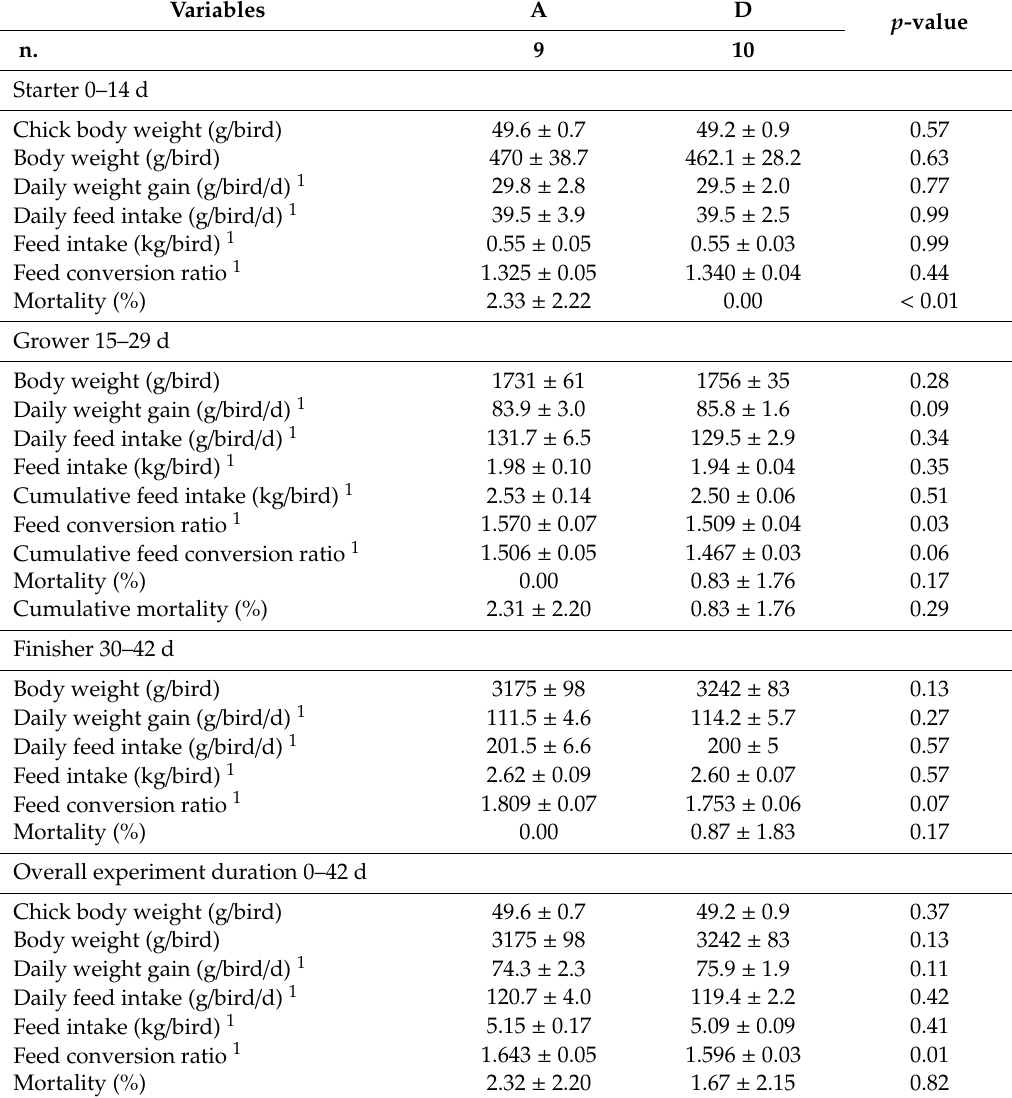
Table 3. Productive performance (mean ± SD) in each feeding phase and in the overall period of the trial *.